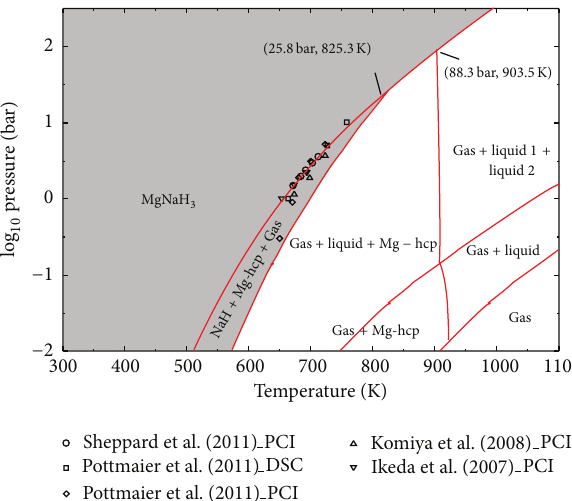
Figure 12: Calculated pressure-temperature equilibrium diagram for NaMgH 3 in comparison with experimental data from the